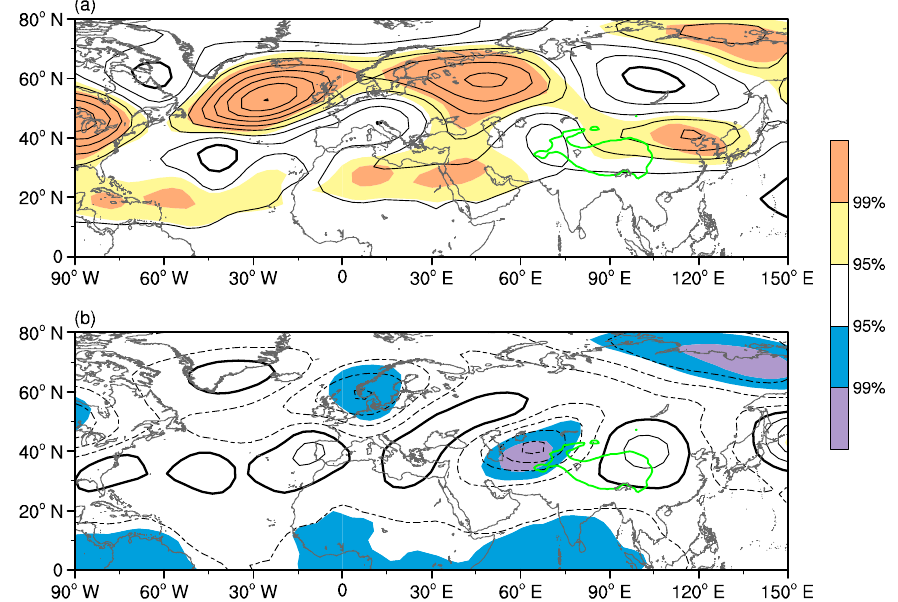
Figure 9. ( a ) Summer 200-hPa geopotential height anomalies (units: gpm) obtained by regression on the April individual high-latitude North Atlantic SST index after removing the variability of the April Indian SM index for the period 1981–2019. ( b ) As in ( a ) but for regression on the April indi- vidual Indian SM index after removing the variability of the high-latitude North Atlantic SST index, in which the April individual Indian SM index is multiplied by − 1 for ease of comparison with ( a ). Contours are drawn every 4 gpm. The bold black line is zero, solid and dash lines denote positive and negative values, respectively. Shadings denote geopotential height anomalies significant at the 95% and 99% confidence levels as shown by the color bars.